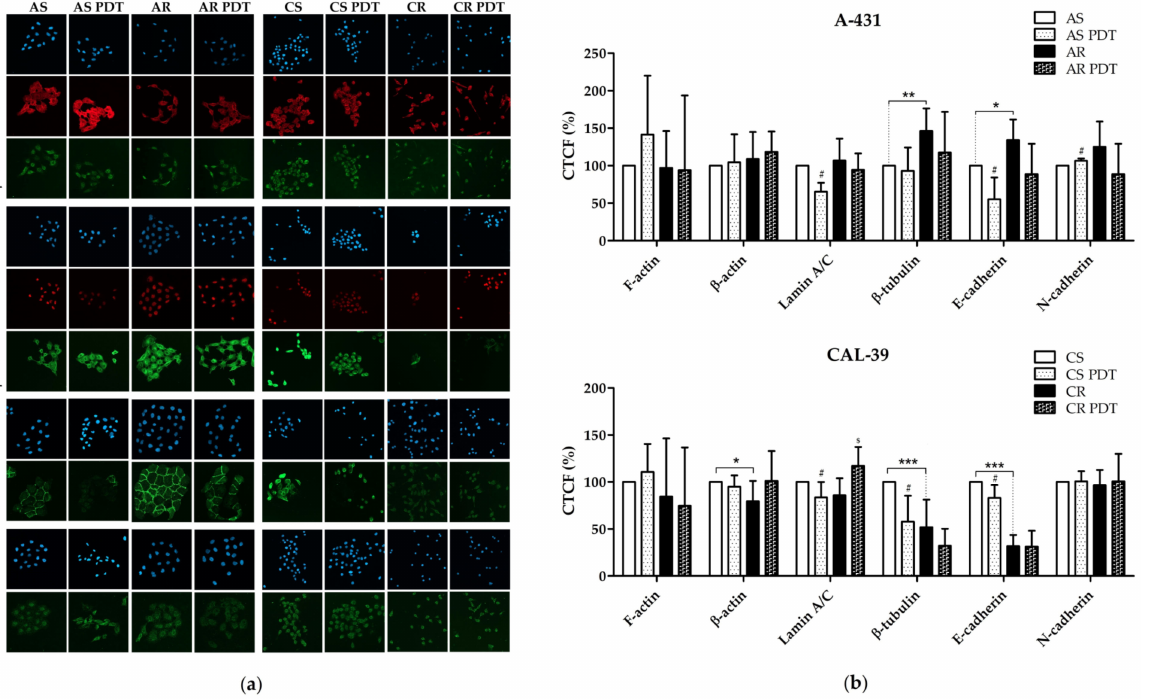
Figure 9. Analysis of the level of actin fibers, selected cytoskeleton proteins and lamin A/C; ( a ) Images of stained cells, before and after PDT treatment. Pictures were taken by the use of Zeiss LSM 800 confocal microscope with 20 × objective. ( b ) Graph with percentage values of CTCF of untreated, parental cells. Statistically significant differences between sensitive and resistant cells (* p ≤ 0.05, ** p ≤ 0.01, *** p ≤ 0.001)) or between untreated and treated cells in sensitive lines: ( # p ≤ 0.05) or in resistant lines ( $ p ≤ 0.05) were calculated via Mann-Whitney